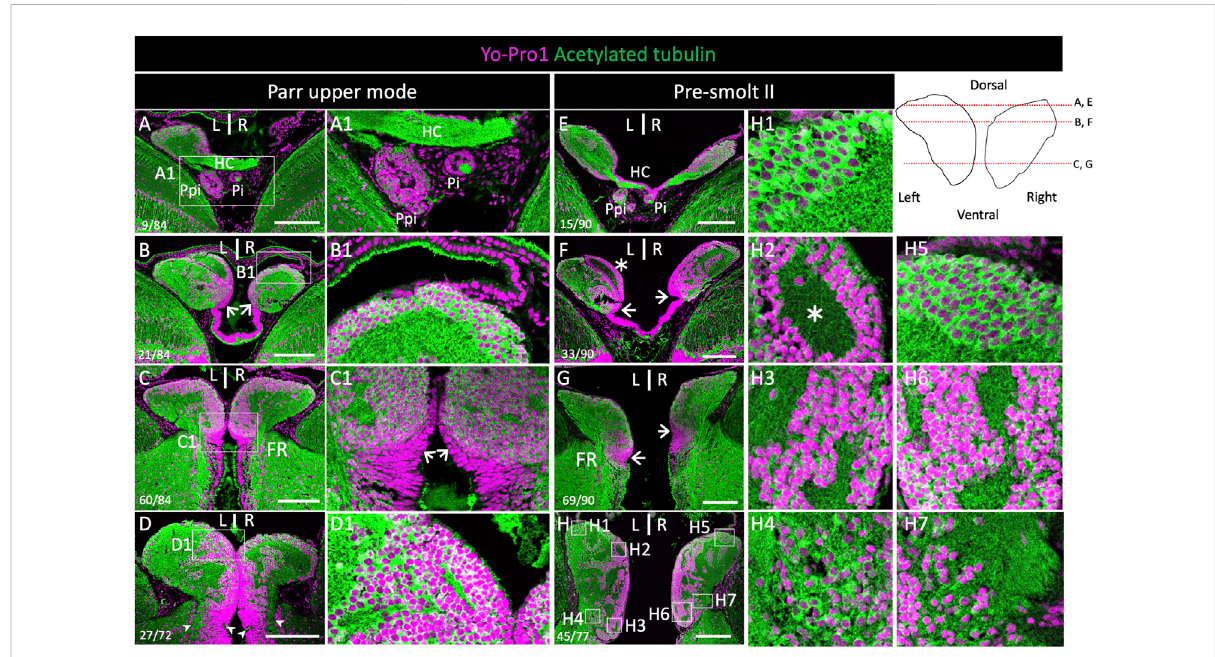
FIGURE 1 Cytoarchitecture of habenulae in Atlantic salmon during smolti fi cation. (A – D) and (E – H) show histological sections of the habenulae in parr upper mode and pre-smolt II respectively, following nuclear staining using Yo-Pro1 (purple) and IHC with an antibody directed against acetylated tubulin (green). (A – G) are horizontalsections, (D,H) aretransverse sections. (A1 – D1) and (H1 – H7) are higher magni fi cationviews of theareasboxed in (A – D) and (H) respectively. Arrowheads in (D) and (H) delimit the ventral border of habenulae. Thin arrows in (B) , (C-C1) , (F) and (G) point towardsventricularcellsharboringapseudo-strati fi edneuroepitheliumorganization.Valuesinthebottomleftcornerof (E – F) refersectionnumbers fromdorsaltoventralhabenulalevelsin (A – C) and (E – G) andfromanteriortoposteriorhabenulalevelsin (D,H) .Thelevelsofhorizontalsectionsare also shown by red lines in the scheme in the upper right panel. Abbreviations: FR, fasciculus retro fl exus; HC, habenular commissure; L/R, Left/Right; Pi, pineal organ; Ppi, and parapineal organ. Scale bar = 200